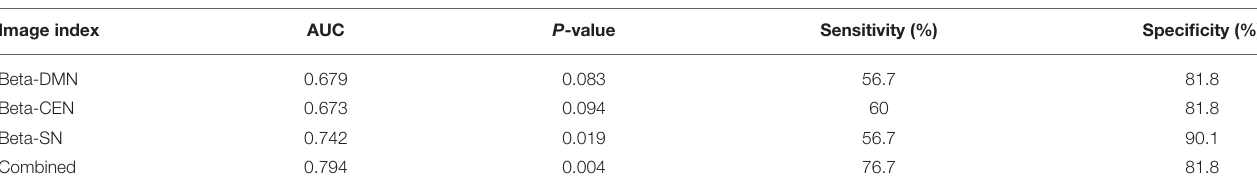
TABLE 3 | ROC of each